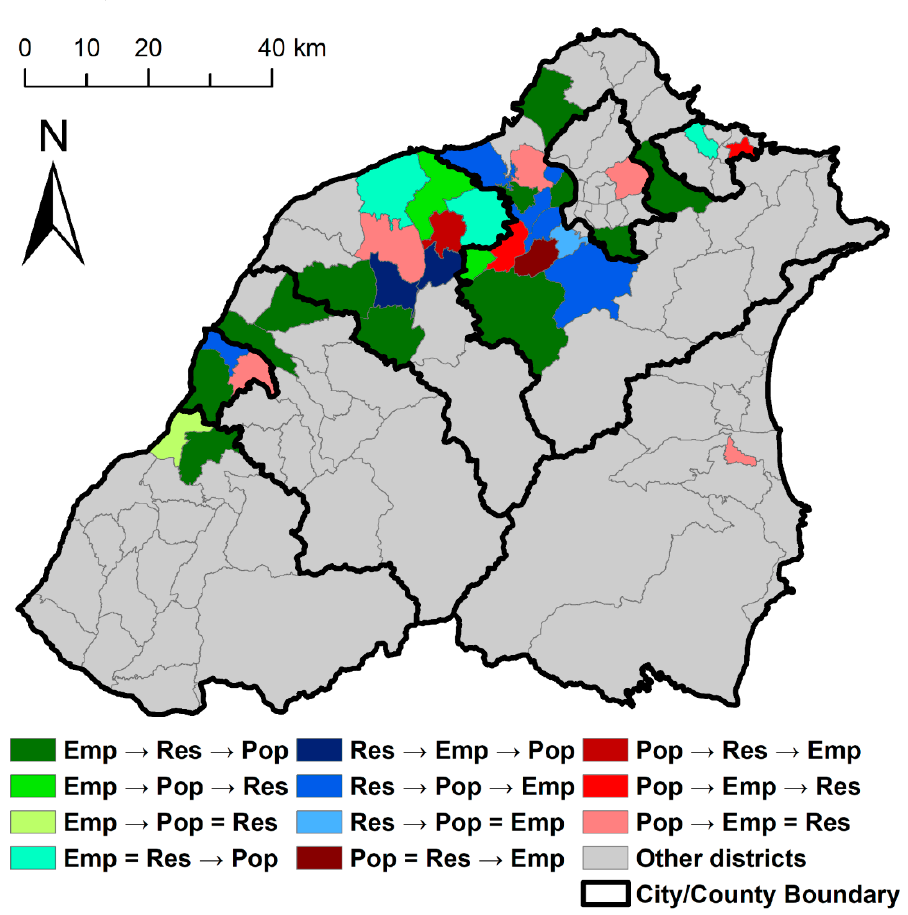
Figure 8. Map of change sequence among population (Pop), Residential (Res), and Employment (Emp) for the 36 districts with greatest population change or population density change. “ → ” indicates one occurred prior to the other. For example, Emp → Res refers that employment expansion occurred prior to Residential. “=” indicates one occurred at the time of the other. For example, Emp = Res indicates Employment and Residential expansion occurred at the same time.